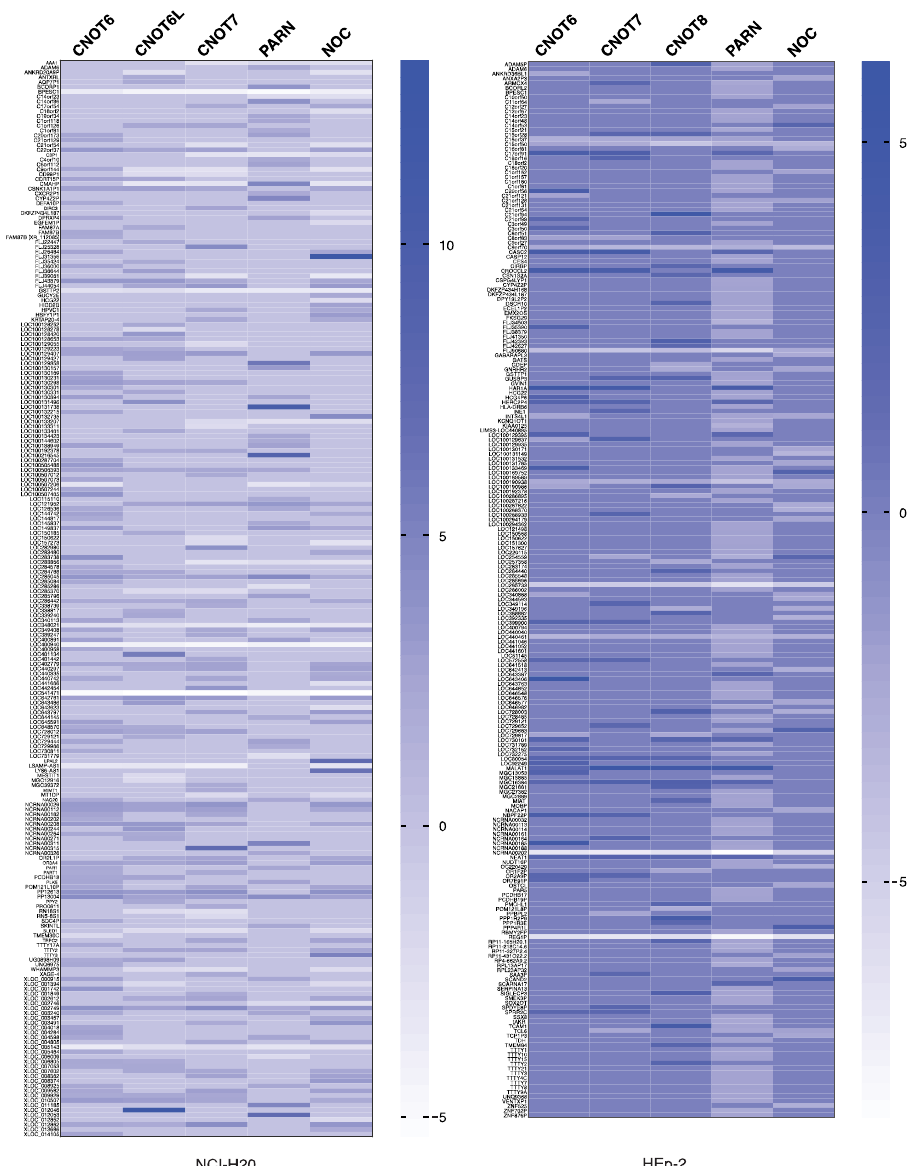
Figure 4. Non-coding RNA transcripts ffected by deadenylase silencing in NCI-H520 and HEp-2 cells. Heat map of differentially expressed non-coding RNA genes (FC ≥ 2.0) upon shRNA-mediated silencing of CNOT6, CNOT6L, CNOT7, PARN, and NOC expression. 2.5. The Silencing of One Deadenylase Affects the Levels of Other Deadenylases